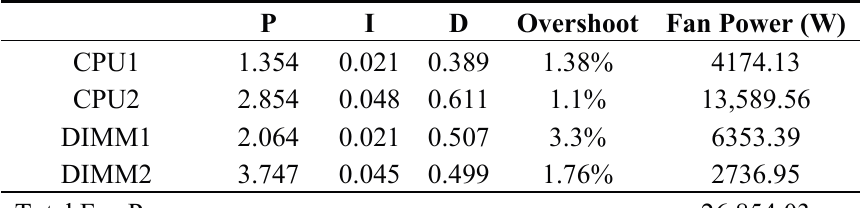
Table 2. PID gains with overshoot and fan power consumption.